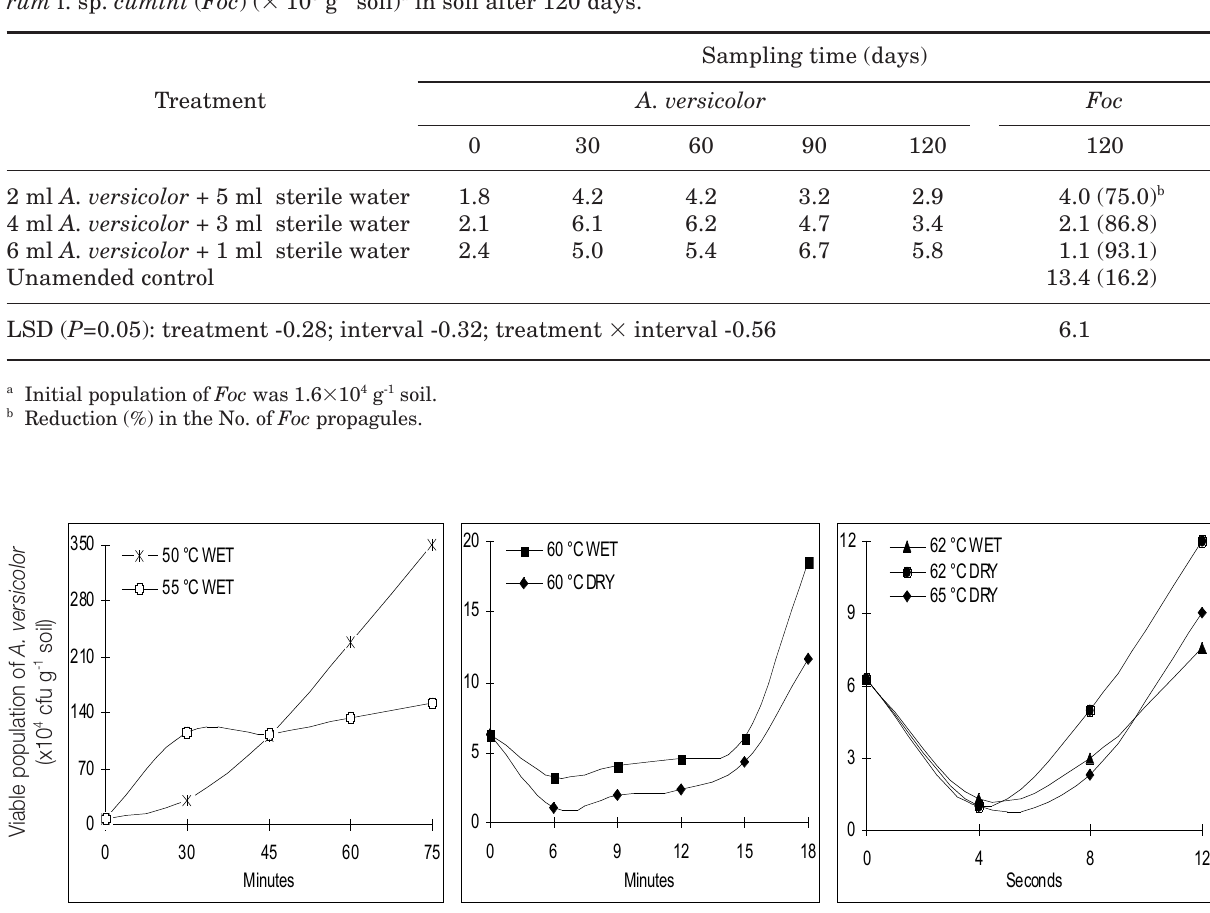
Table 3. Effect of culture concentrations on survival of Aspergillus versicolor ( (cid:1) 10 7 g -1 soil) and Fusarium oxyspo-